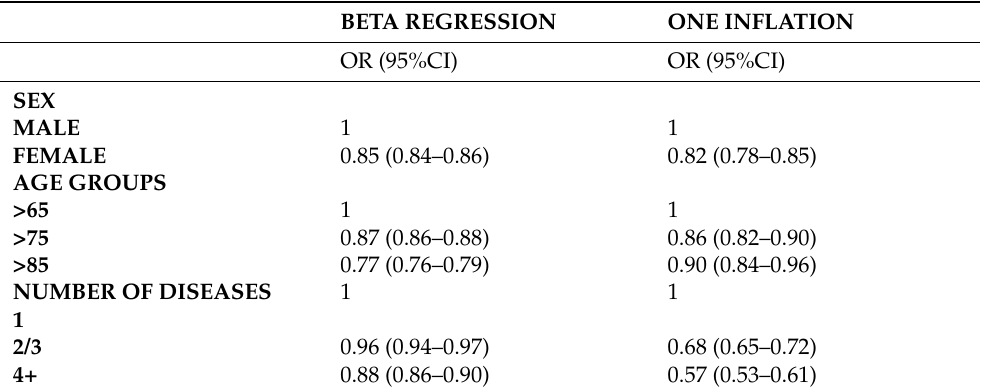
Table 2. One-inflated beta regression model for assessing factors associated with multiple medication adherence (DPPR) (odds ratios and corresponding 95% confidence intervals).